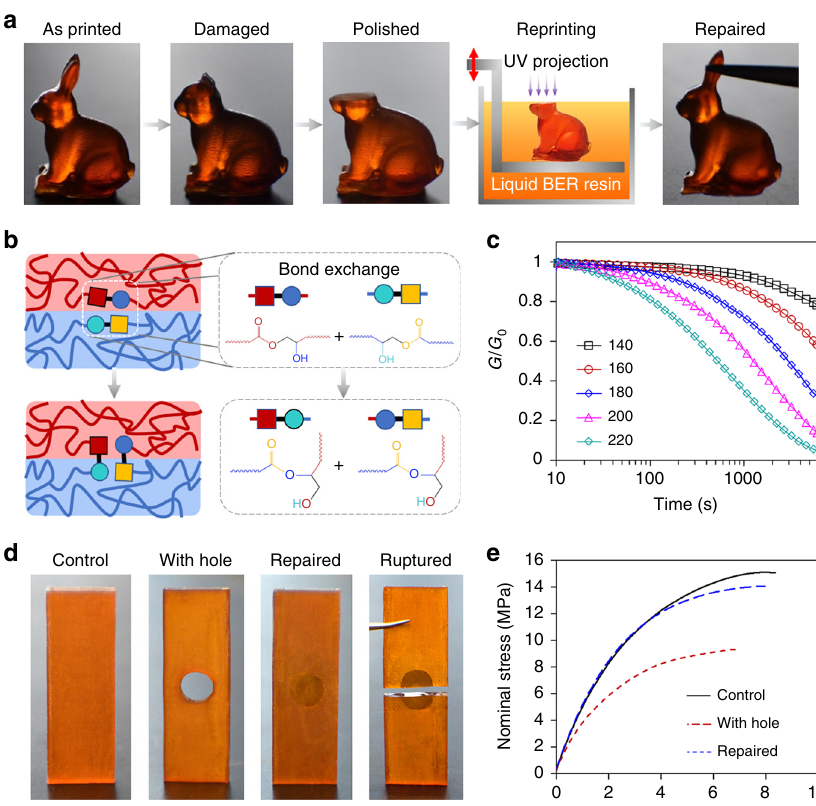
Fig. 3 Repairability of the 3D printing reprocessable thermosets. a Demonstration of the ability of the material to repair fl awed printed structures: surgery on a damaged rabbit. b Illustration of the repair process due to the BER. c The temperature effect on stress relaxation of printed samples. d , e Uniaxial tensile tests to examine the repair performance. d Photos of the control sample, a sample printed with a hole, a repaired sample, and a ruptured sample after repair. e Comparison of the nominal stress (force divided by cross-section area of control sample) vs. strain for the samples in